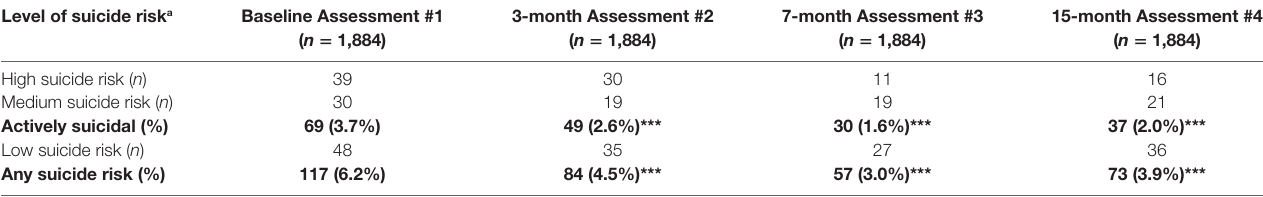
Findings in bold indicate key outcome measures. a According to algorithm (41). ***p < 0.001 compared to baseline.